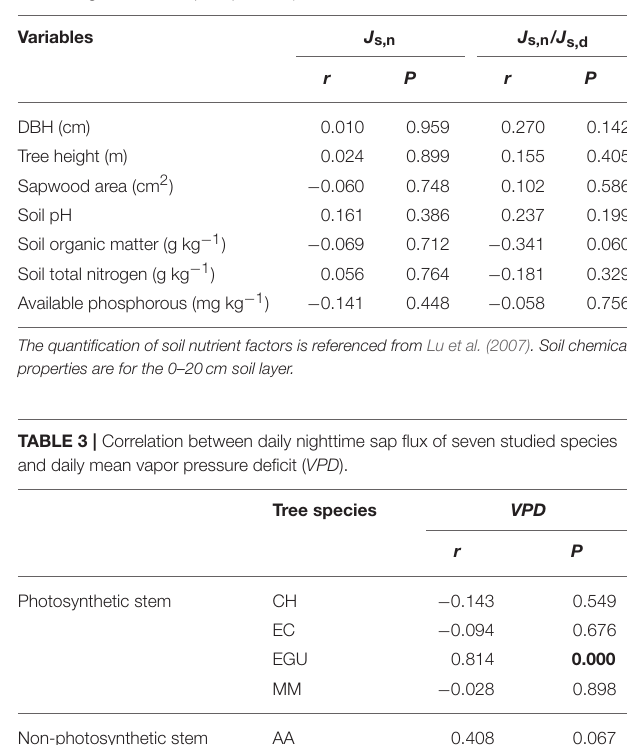
FIGURE 1 | Diurnal patterns of sap flux density in seven studied trees. CH, Castanopsis hystrix ; MM, Michelia macclurei ; EC, Eucalyptus citriodora ; EGU, Eucalyptus grandis × urophylla ; CF, Castanopsis fissa ; SS, Schima superba ; AA, Acacia auriculiformis . Data point is the average of all days across the study period; bars indicating SD are omitted for clarity.